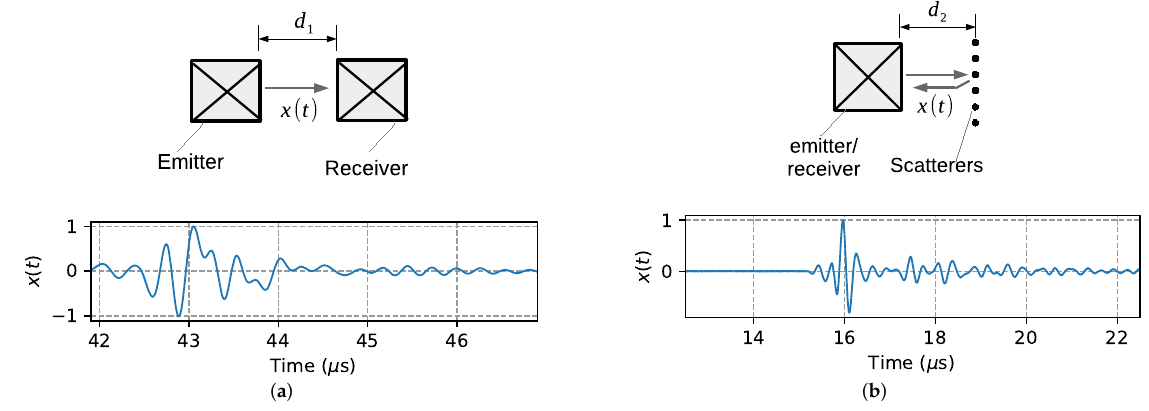
Figure 1. Experimental configurations and waveforms of ( a ) transmission–reception and ( b ) backscat- tering modes. ( a ) TRD. ( b )